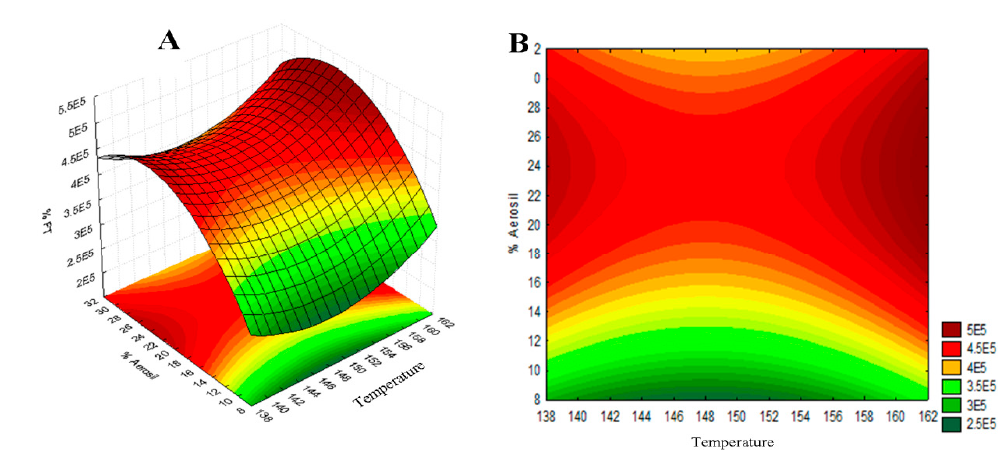
Figure 3. Surface response graph 3 2 for temperature and Aerosil ® percentage factors in relation to total flavonoid content. Surface response in 3D ( A ) and 2D contour plot ( B ).